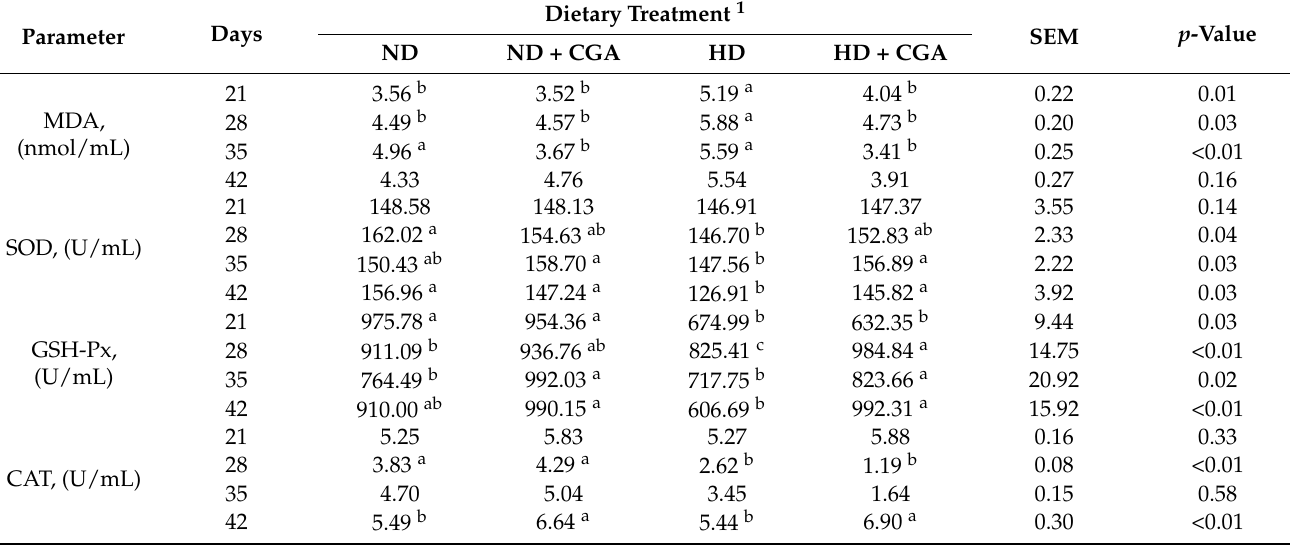
Table 3. Effects of CGA on serum antioxidant parameters of broilers under HD stress.